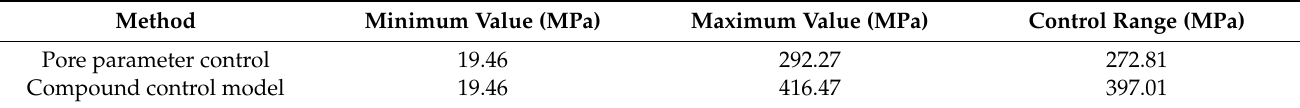
Table 5. Comparison of control